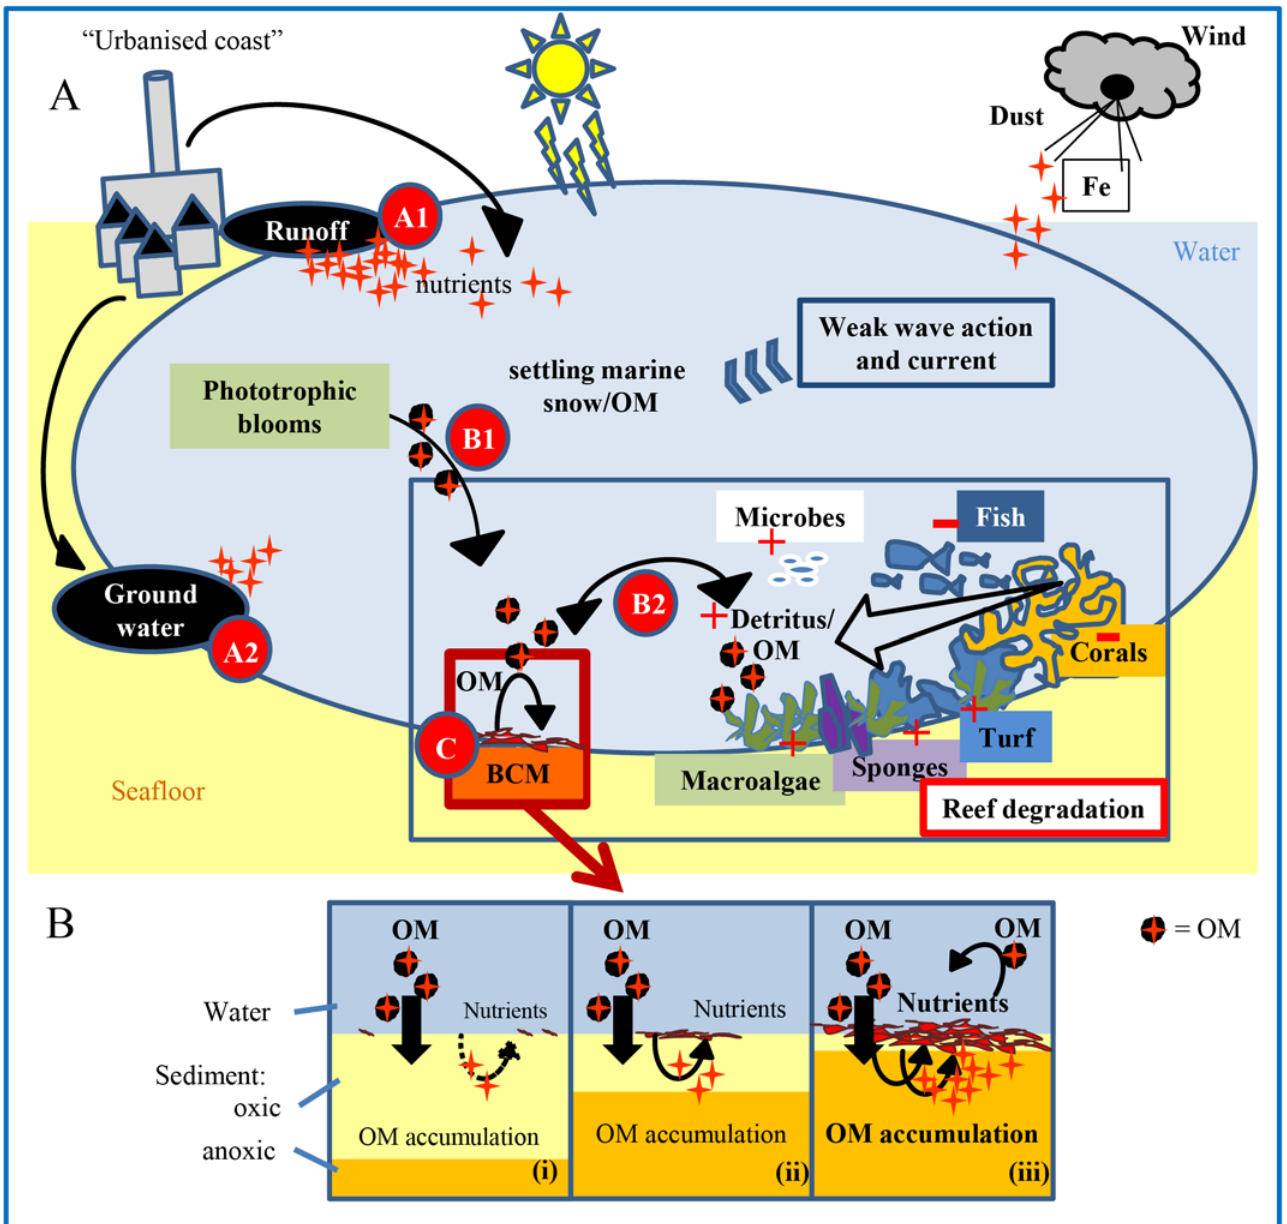
Fig 6. Proposed explanatory model. (A) Proposed model of sources and cycle of nutrients stimulating BCM growth. Nutrient inputs from land runoff (A1) or groundwater seepage (A2) cause benthic and planktonic phototrophic blooms. Fe is largely available as a result of long-term Fe addition by the African dust [54]. The blooms decay and produce particulate OM (B1) which settles on the seafloor as a function of wave action and current. The coral reef community takes up, produces and releases OM (B2) [18,33,50,68]. Reef degradation leads to a detritus-based food web and enhances OM accumulation on the seafloor. Increased OM loading leads to BCM growth via the release of nutrients from the microbial degradation of OM (C). (B) Schematic drawing of the water/sediment interface. Drawings from far away from (i), near to (ii), and middle of (iii) BCM patches are used as analogs for what we anticipate as OM accumulates over time. Increased OM concentration in the sediments results in a thinner oxygenated surface layer and an increased nutrient release, which triggers BCM growth. When BCMs develop, they produce OM and trap OM from the water column to sustain their growth and expand.